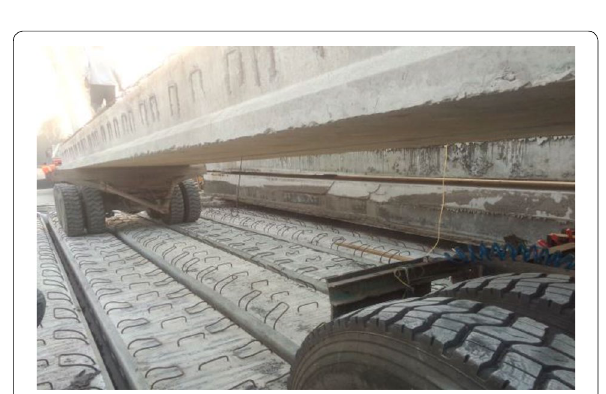
Fig. 3 Concentrated force loading